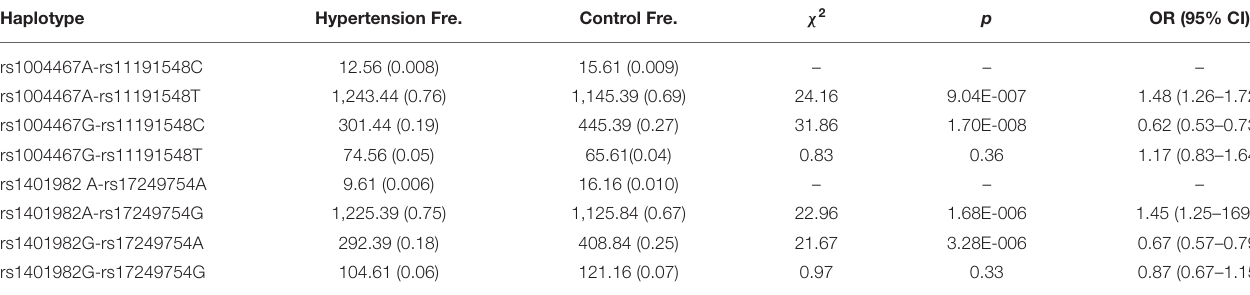
TABLE 3 | Association between the haplotypes and hypertension risk. Haplotype Hypertension Fre. Control Fre.